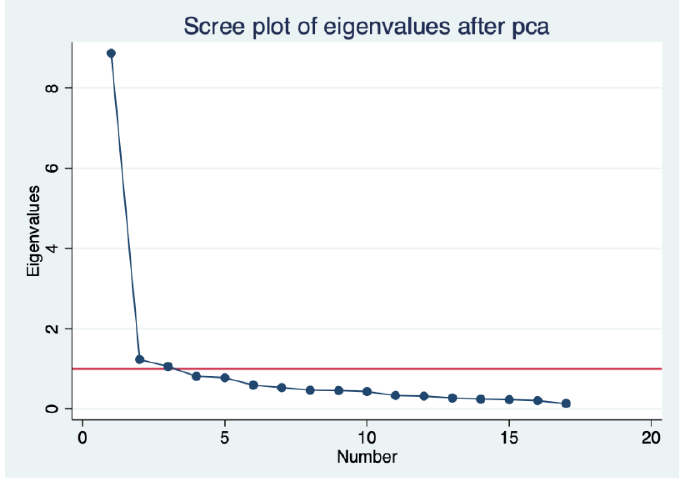
Figure 1. Scree plot of eigenvalues.